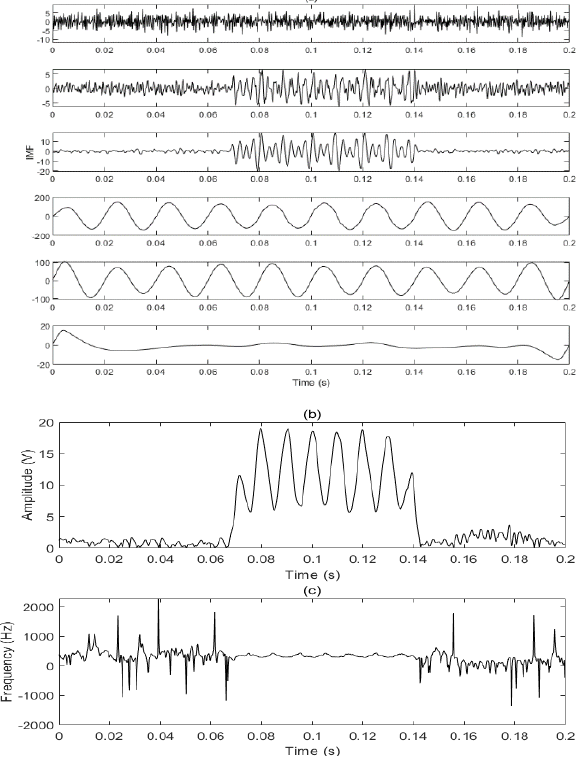
Figure 19. Impulsive transient IMF components ( a ), amplitude ( b ), and frequency ( c ).